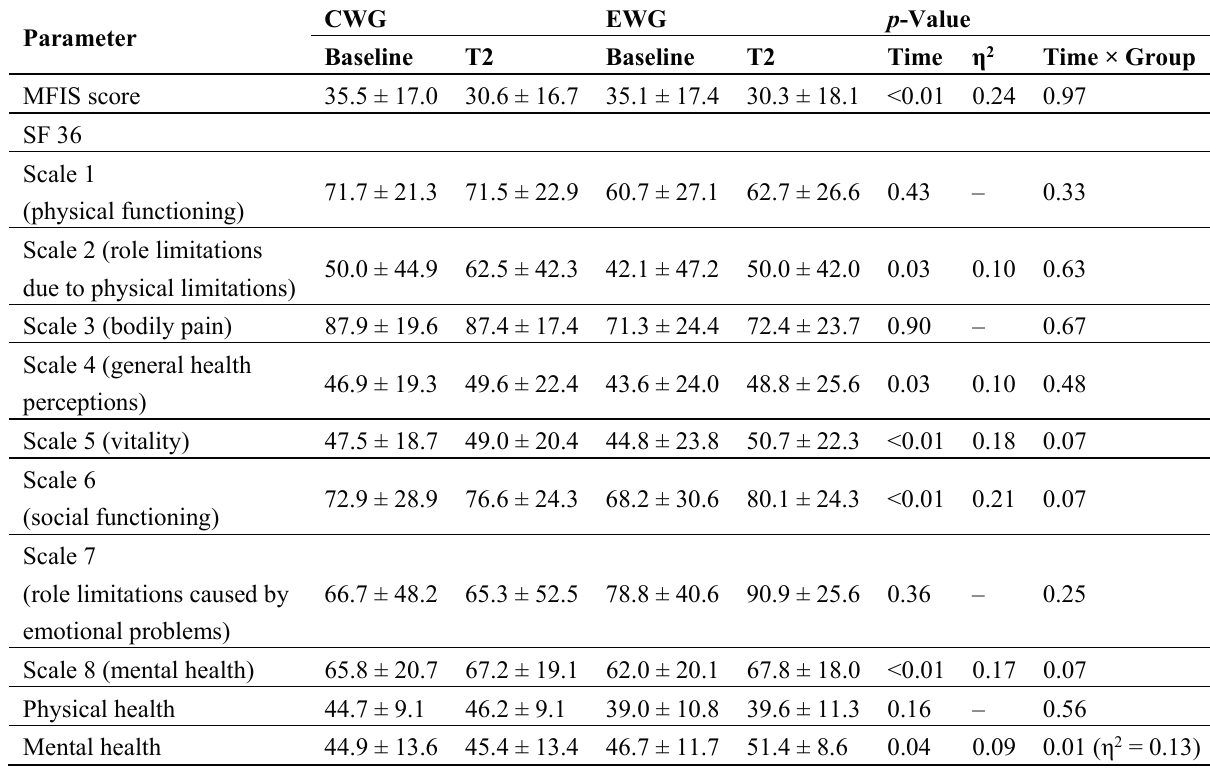
Table 4. Questionnaire parameters at baseline and after training